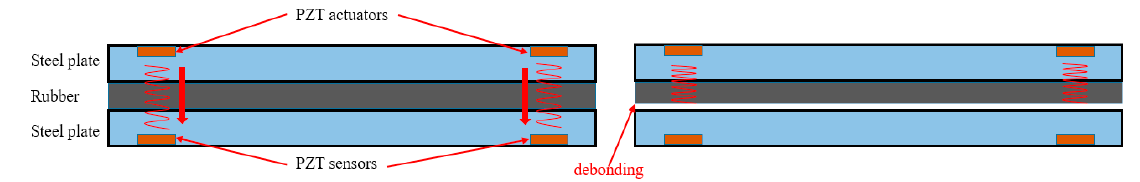
Figure 1. Schematic of the active sensing approach in the application of the detection of the rubber–steel bond failure.